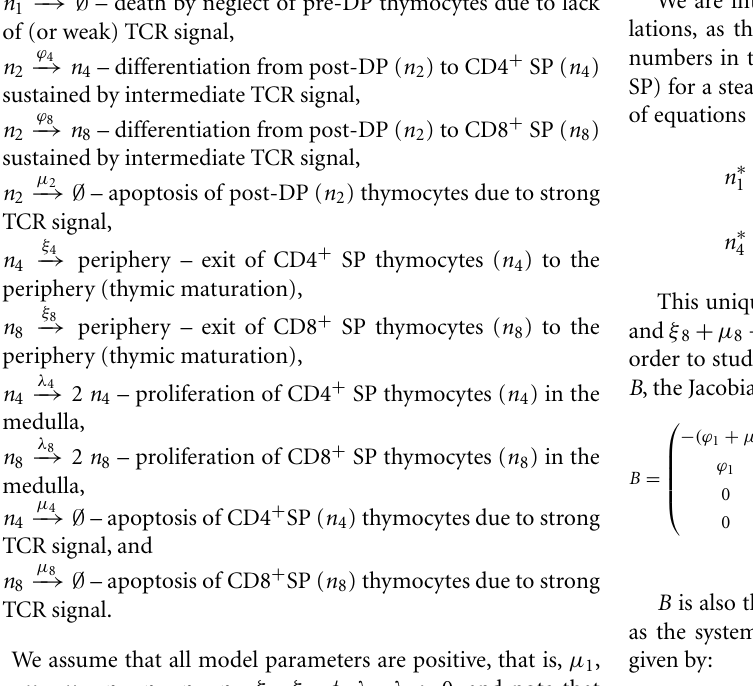
FIGURE 2 |Thymic development as hypothesized in the second model . We assume there is a flux, φ , that represents the differentiation of DNs into pre-DPs. Pre-DP thymocytes have two fates: further differentiation into the post-DP pool ( ϕ 1 ) or death by neglect ( µ 1 ). Post-DP thymocytes have three